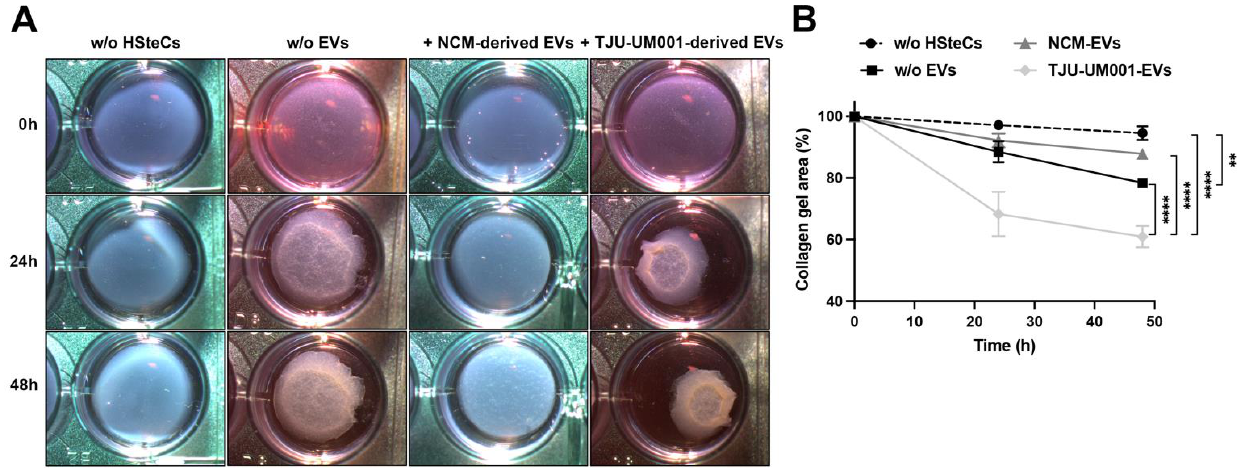
Figure 7. UM-derived EVs increase collagen gel contraction by stellate cells. ( A ) Representative images of collagen gels (1 mg/mL) without embedded HSteCs, with embedded HSteCs not treated with EVs, and with embedded HSteCs treated during 24 h with large EVs derived from NCMs or metastatic UM cell line TJU-UM001 taken with a stereomicroscope. ( B ) Corresponding quantification of the collagen gel area (in percentage) for each condition during 48 h. Error bars indicate ±SEM ( n = 3); ** p < 0.01 and **** p < 0.0001 (two- way ANOVA with Sidak’s multiple comparisons test).